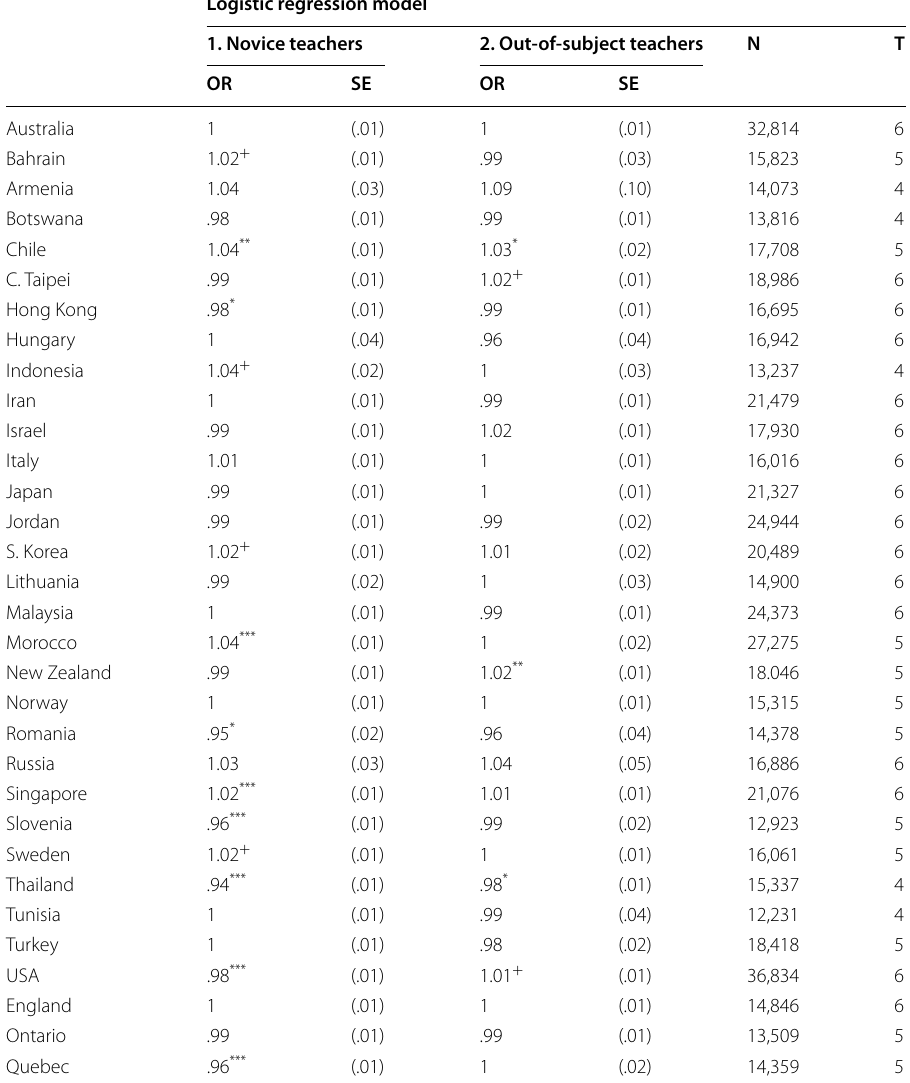
Table 1 Estimated linear trends for novice and out-of-subject teacher sorting by education system